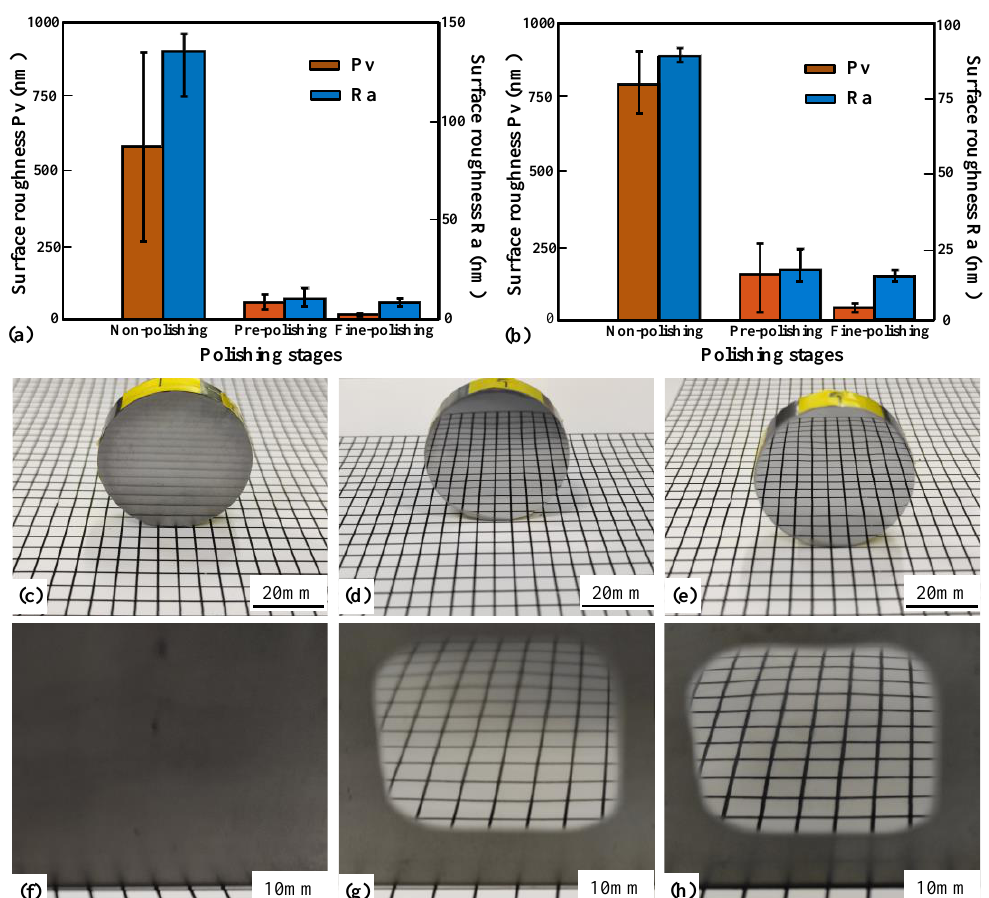
Figure 5. Roughness at different polishing stages measured using a PGI Dimension 3 and corre- sponding photographs. ( a ) Surface roughness comparison of WC-0Co at different polishing stages; ( b ) surface roughness comparison of WC-12Co at different polishing stages. Photographs of WC-0Co samples: ( c ) before polishing, ( d ) after pre-polishing and ( e ) after fine polishing. Photographs of WC-12Co samples: ( f ) before polishing, ( g ) after pre-polishing and ( h ) after fine polishing.